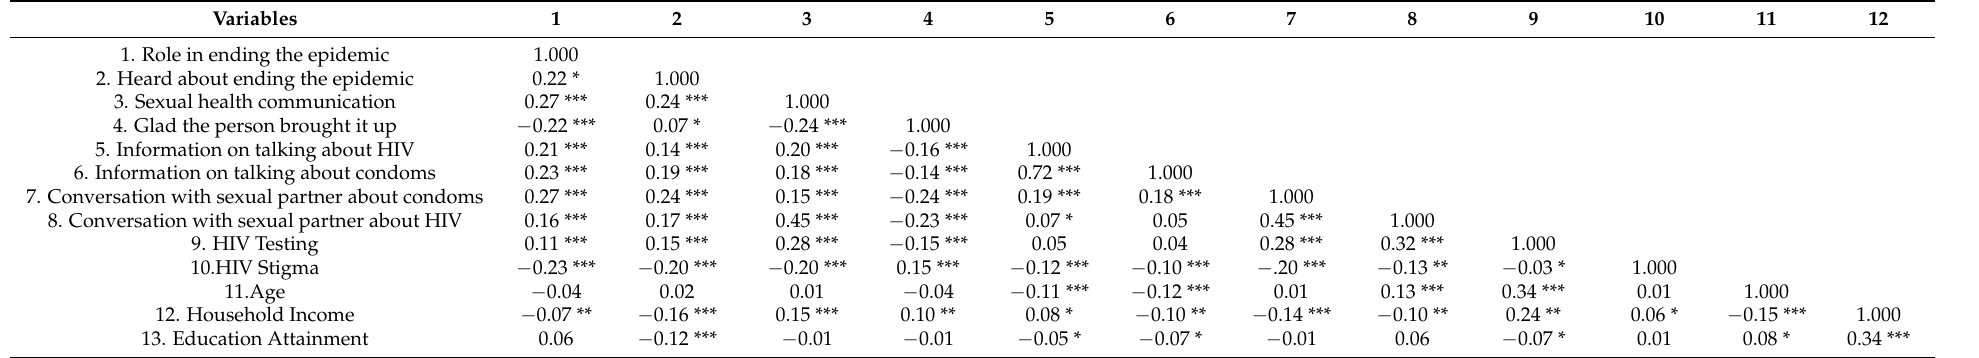
Table 2. Bivariate correlations, means, and standard deviations of the study variables ( n =